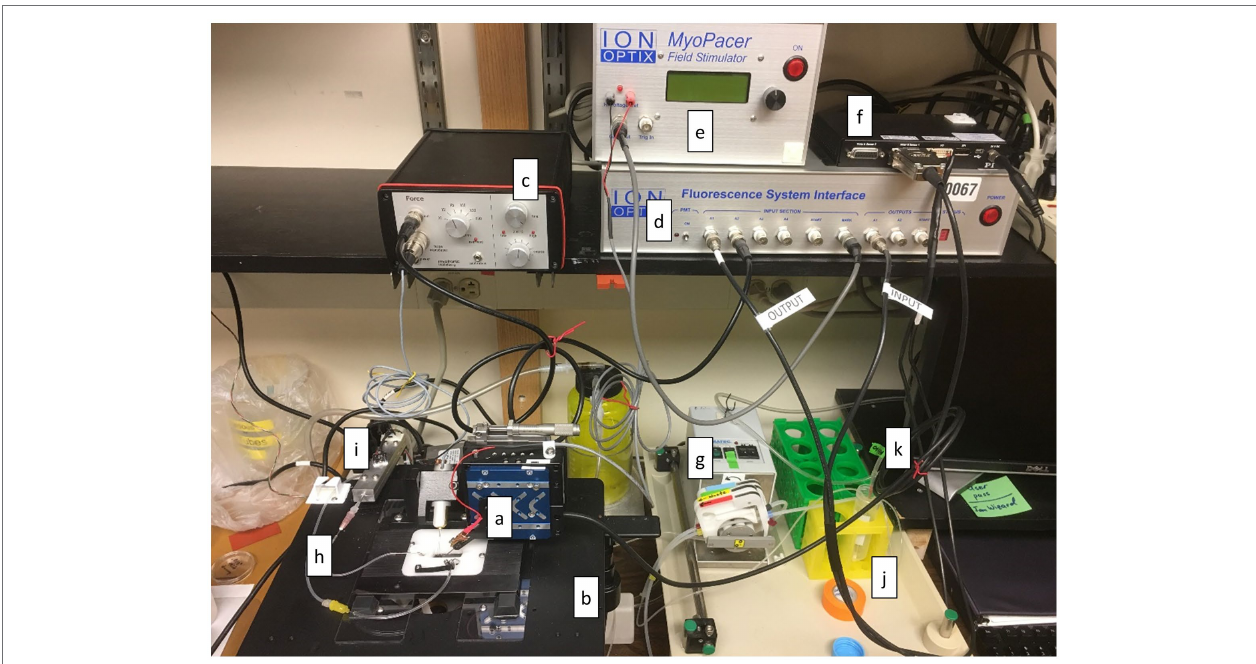
FIGURE 8 | Recording Station. The equipment and tools required to record data associated with muscle function are shown here. (a) chamber fitted with force transducer and length adjuster, (b) inverted microscope with 20X, 25X, or 40X fluorescence objective, (c) bridge amplifier for force transducer, (d) electronic interface and computer required for data collection, (e) stimulator, (f) motor controller, (g) peristaltic circulating pump, (h) tubing for delivery and withdrawal of circulating solution, (i) in-line heater to warm the solution prior to delivery to chamber, (j) rack for holding beakers or tubes containing perfusion solutions, (k) bubbling stone to deliver gases to the perfusion